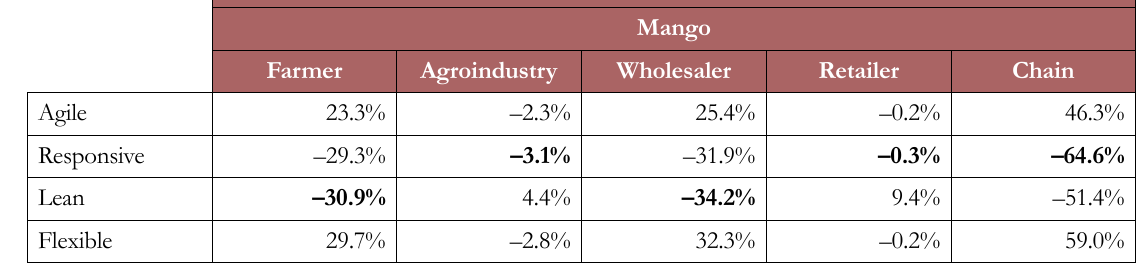
Table 5a. Waste Inventory for Mango